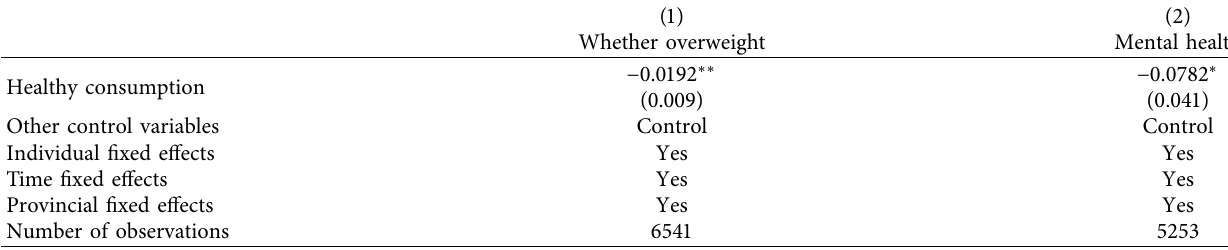
Table 7: Physiological health and mental health regression results.